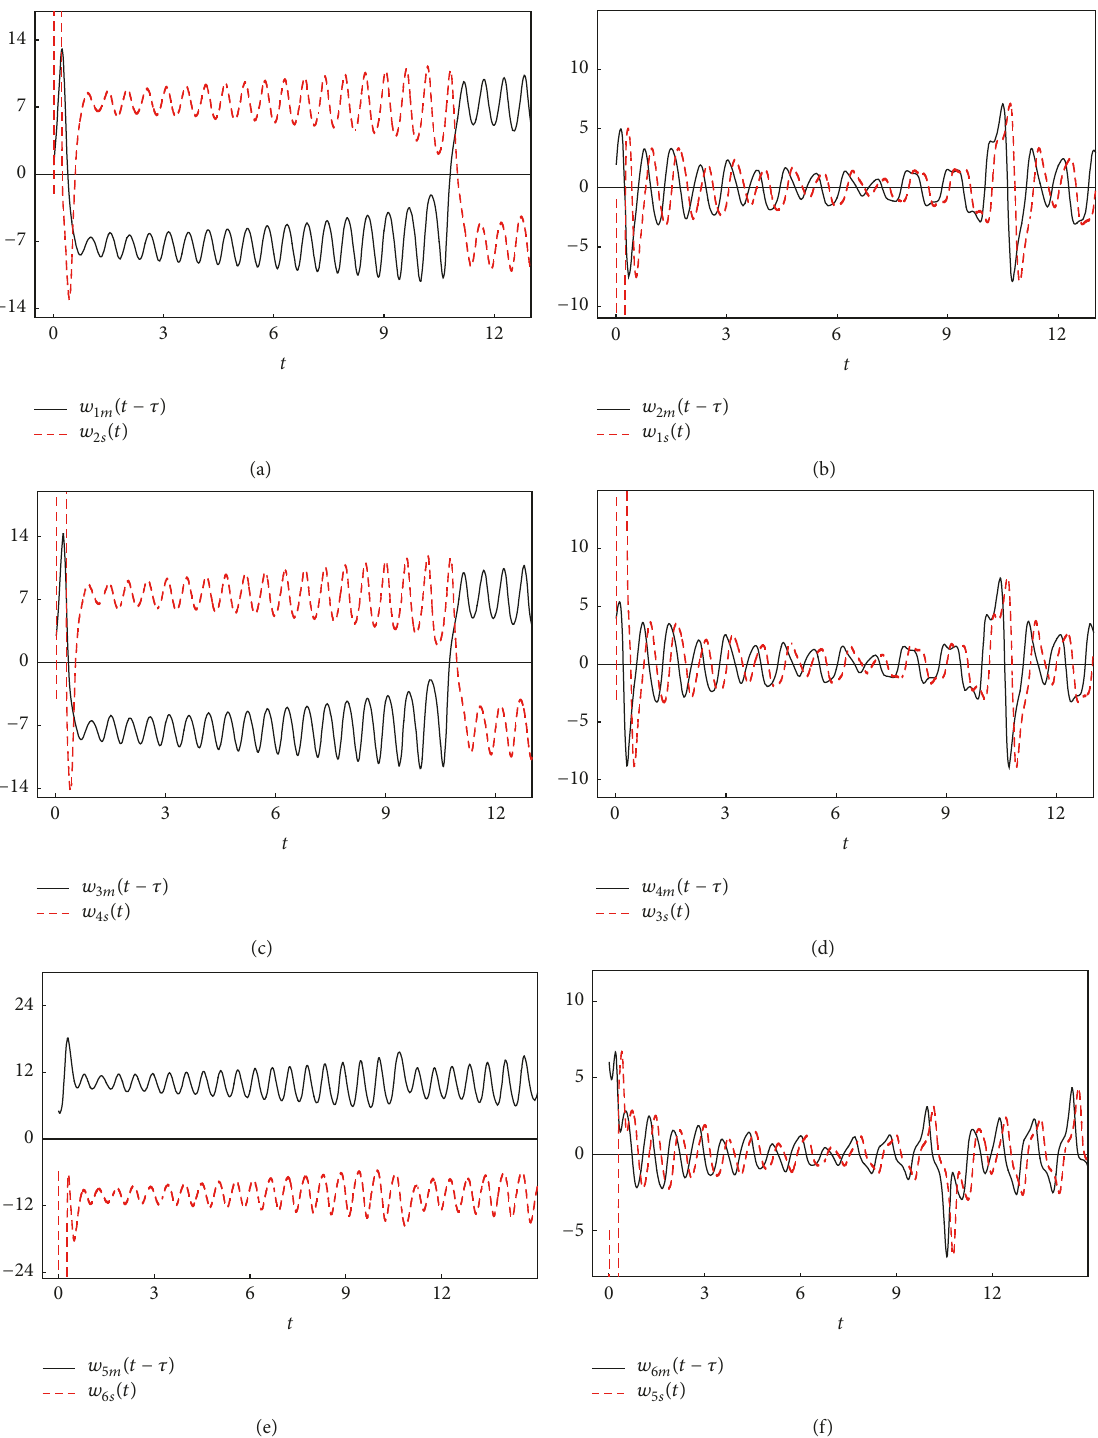
controller (40) are illuminated numerically, and the parame- ters are picked as 𝜌 = 23 , 𝜇 = 6 , and 𝜐 = 10 . The underlying the slave models 𝜉, 𝜏 are considered basically (𝑥 𝑚 (0), 𝑦 𝑚